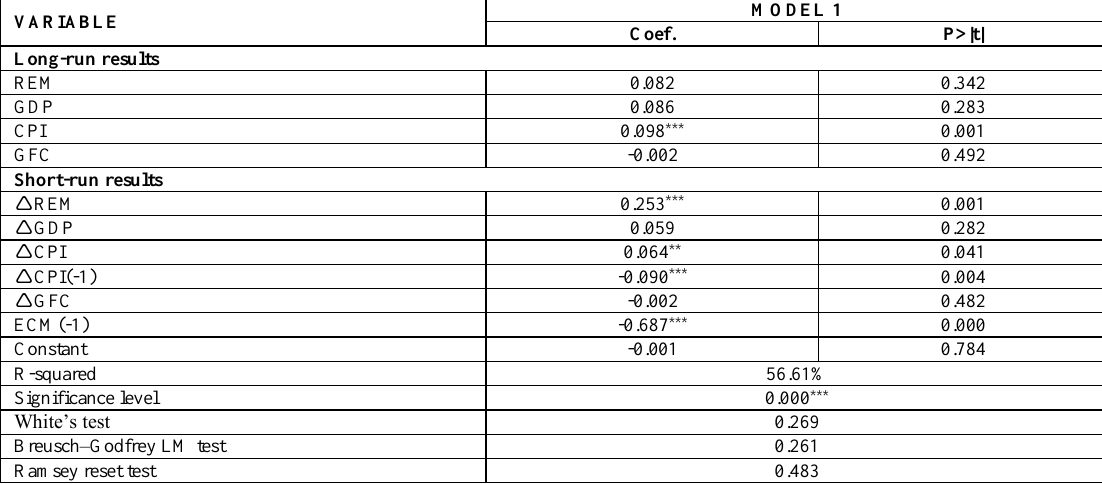
Table 4. Coefficient estimation results (Model